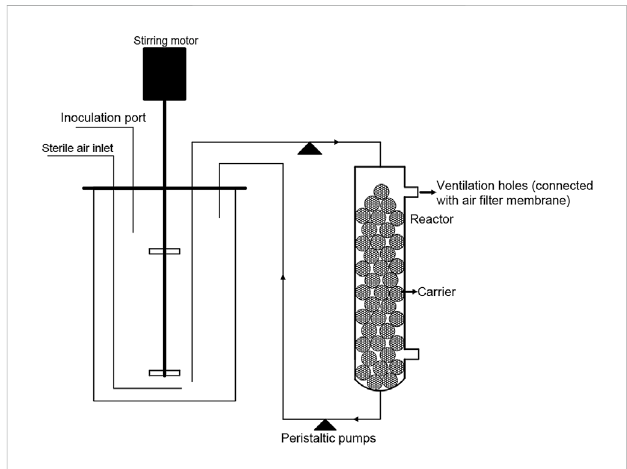
Schematic diagram of the two-compartment bio fi lm